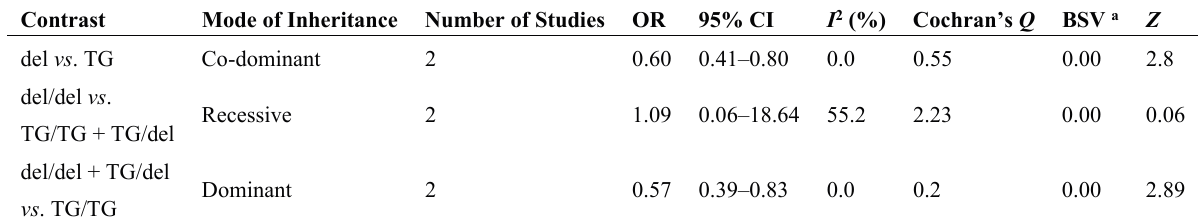
Table 5. Univariate meta-analysis for the 1527–1528 TG>del polymorphism of the CD24 gene with multiple sclerosis.